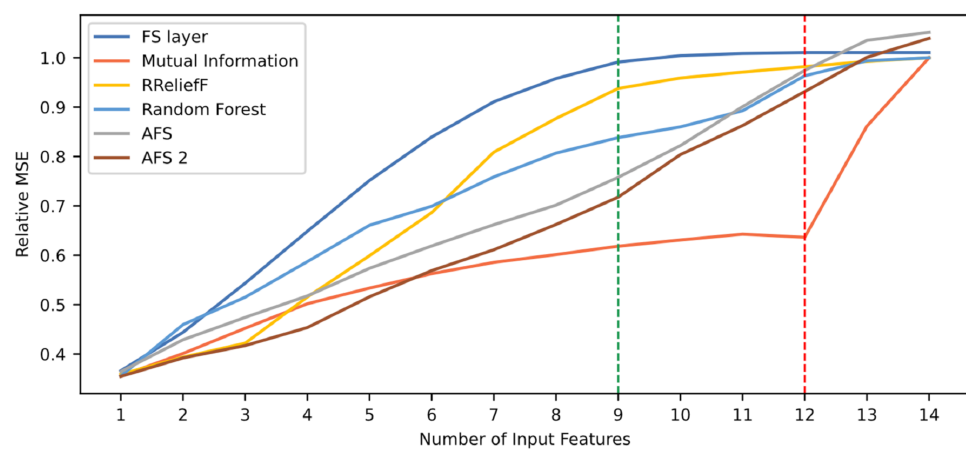
Figure 11. Comparison of relative MSE according to six different rankings. The red and green dotted lines indicate the number of features needed when using the FS layer technique to reach maximum performance and a 95% of this value,